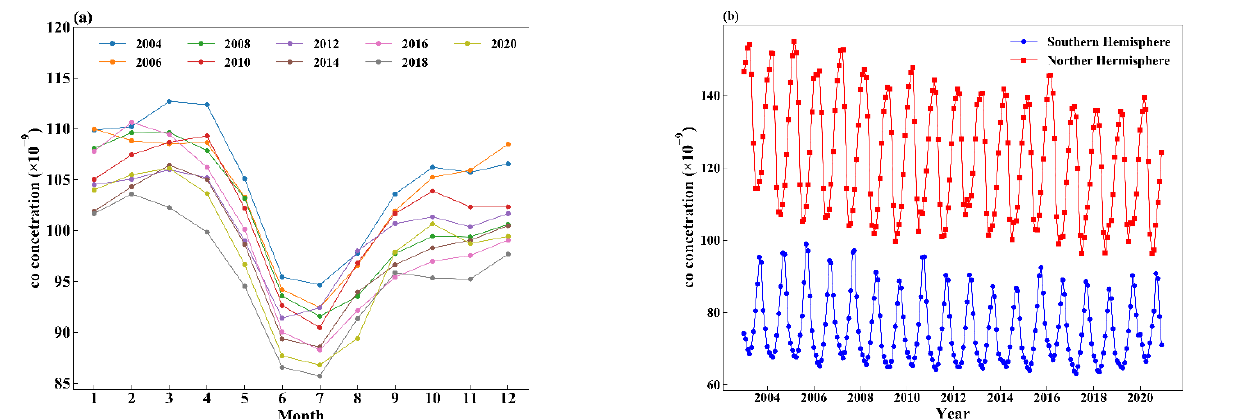
Figure 3. Monthly average variation diagram of global average CO concentration 850 hPa pressure layer from January 2003 to December 2020. ( a ) Global monthly average in even years; ( b ) Monthly average in the northern and southern hemispheres.